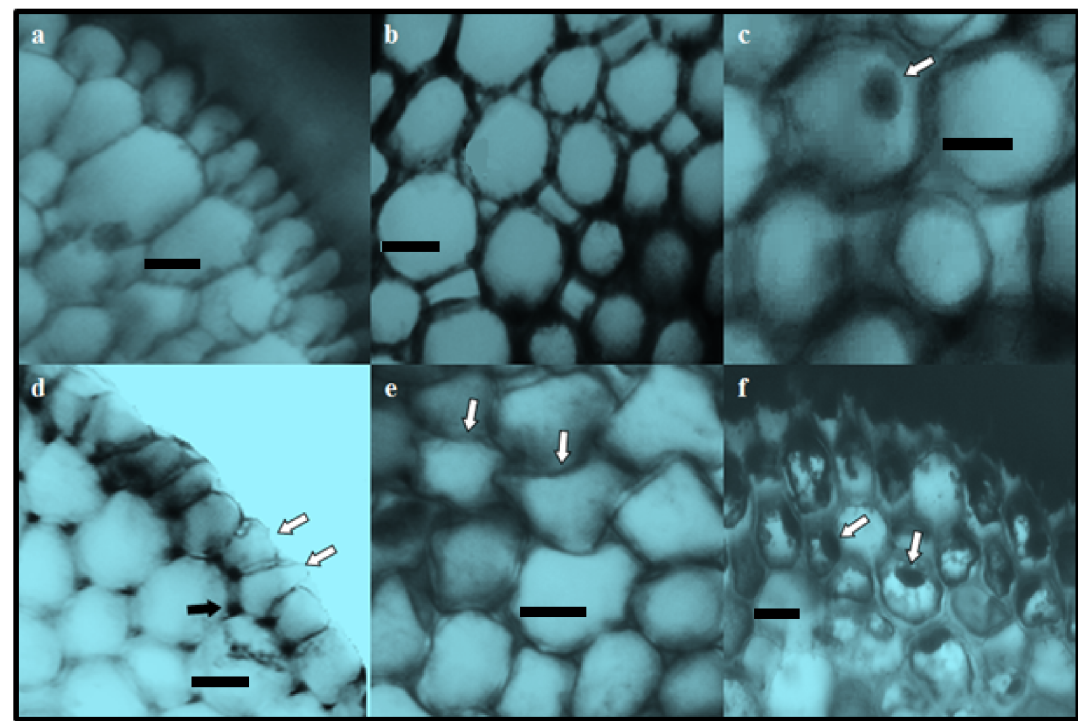
Figure 4. Anatomical damages induced by metaldehyde in root tip meristem cells. Normal appearance of epidermis cells ( a ), normal appearance of cortex cells ( b ), normal appearance of cell nucleus—oval, ( c ) epidermis cell damage—white arrows, thickening of the cortex cell wall—black arrow ( d ), cortex cell damage ( f ), flattened cell nucleus ( g ) (scale bar = 50